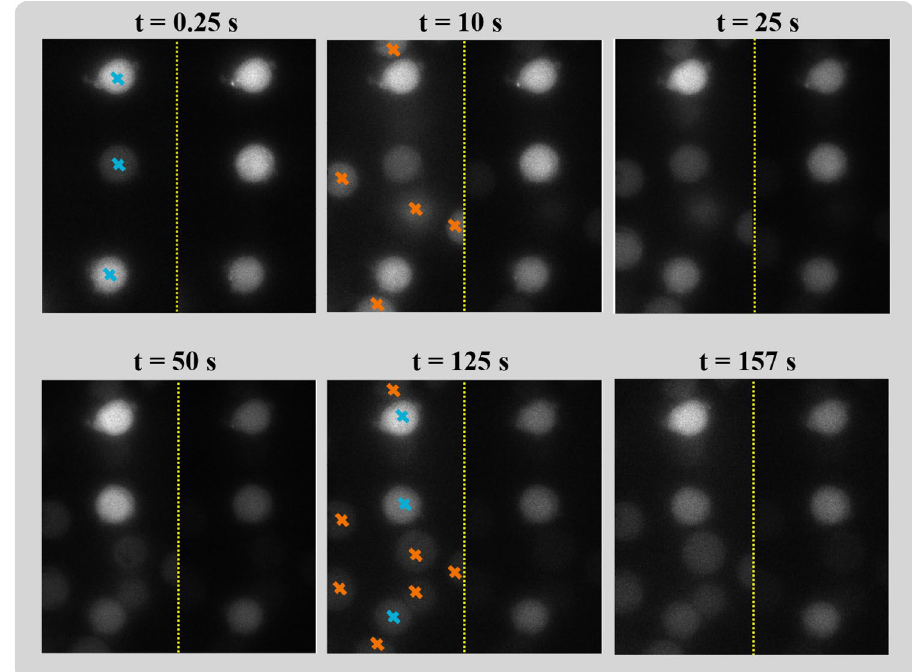
Figure 3. Six snapshots (with 500 × 500 pixels) of fluorescence intensity measured with Fluo-4 (left to the yellow border) and Fura Red (right) emissions. Cells are marked with blue crosses and beads with orange crosses at first appearance and, for further clarification, at t = 125 s. While there is no bead at t = 2.5 s, at t = 10 s, five and at t = 25 s, six beads are observable in the Fluo-4 images. The beads are not captured by Fura Red. Visible in all Fura Red images, three Jurkat T-cells with different sizes, shapes, and temporal activities are present [Graphics created with MATLAB and the Image Processing Toolbox Release 2019b, The MathWorks, Inc. (http:// mathw orks. com/ produ cts/ image.